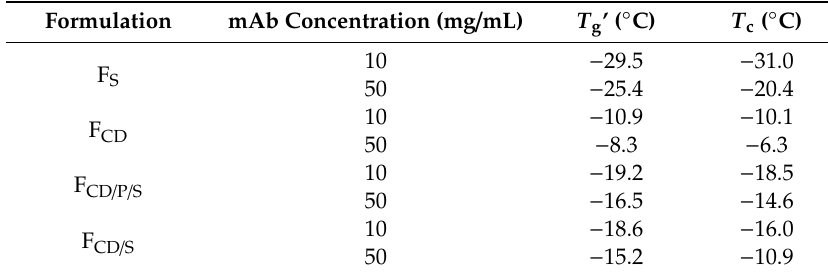
Table 2. Critical formulation temperatures. Glass transition temperature ( T g ’) and onset of collapse temperature ( T c ) of the liquid